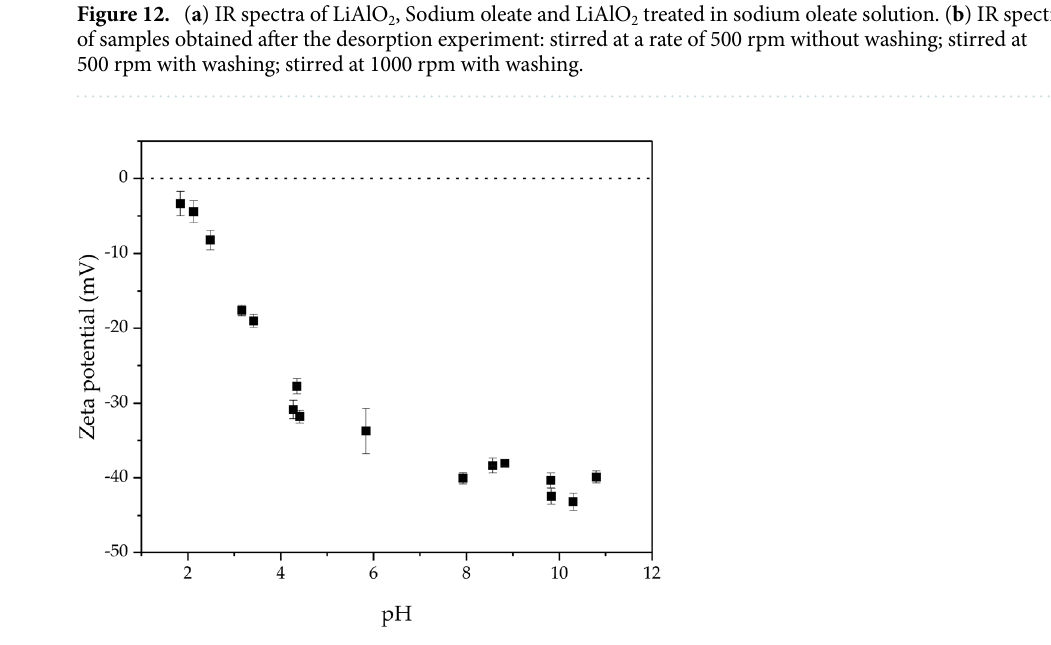
Figure 13. Zeta potential of Melilite